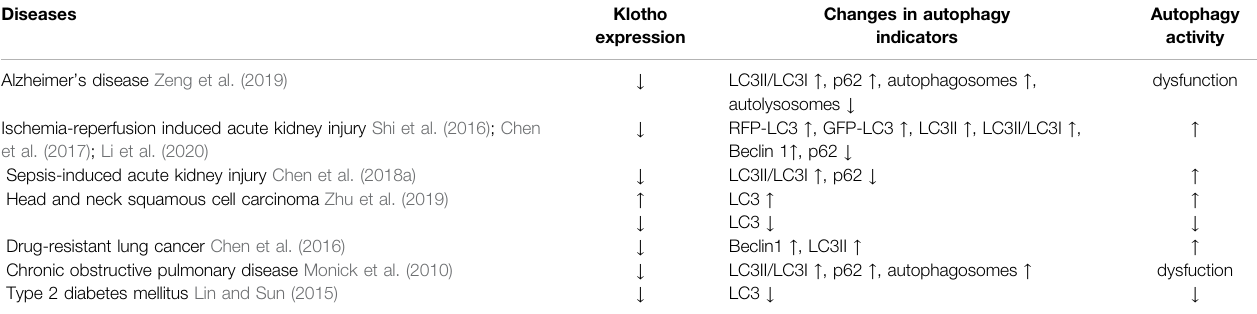
TABLE 1 | Correlation between Klotho expression and autophagy activity in certain diseases, as reported in observational